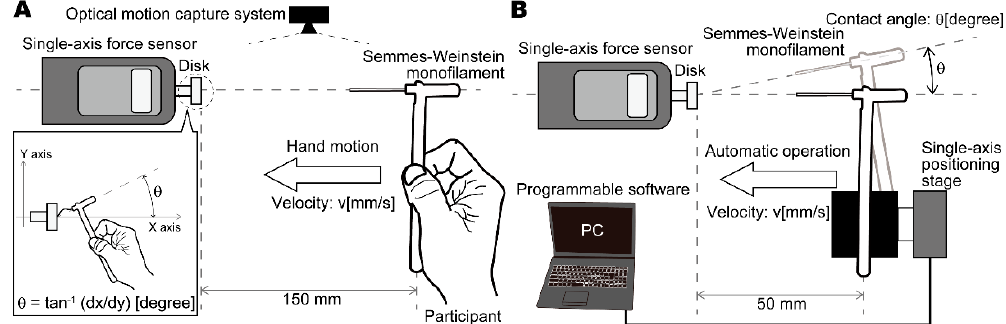
Figure 1. Experimental measurement apparatus: ( A ) under manual (human) operation, hand motion during monofilament application is measured using an optical 3D motion capture system, and the monofilament buckling force is measured using a single-axis force sensor; ( B ) under automated operation, the monofilament is applied using a single-axis positioning stage controlled by a stepping motor and a personal computer with programmable software.